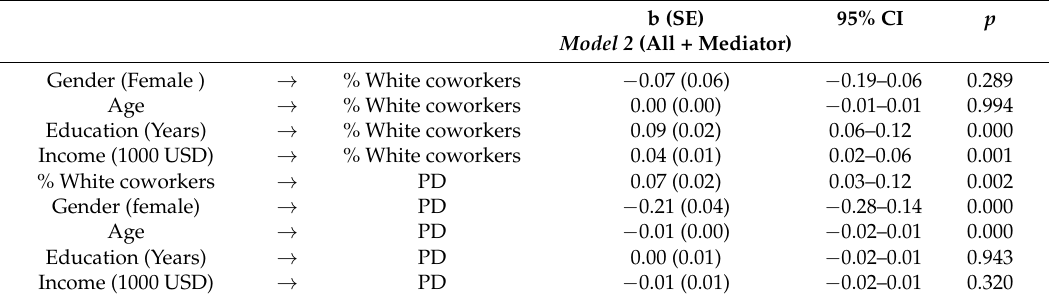
Table 2. Summary of path coefficients for the effects of household income and educational attainment on perceived discrimination via racial composition of workplace in the pooled